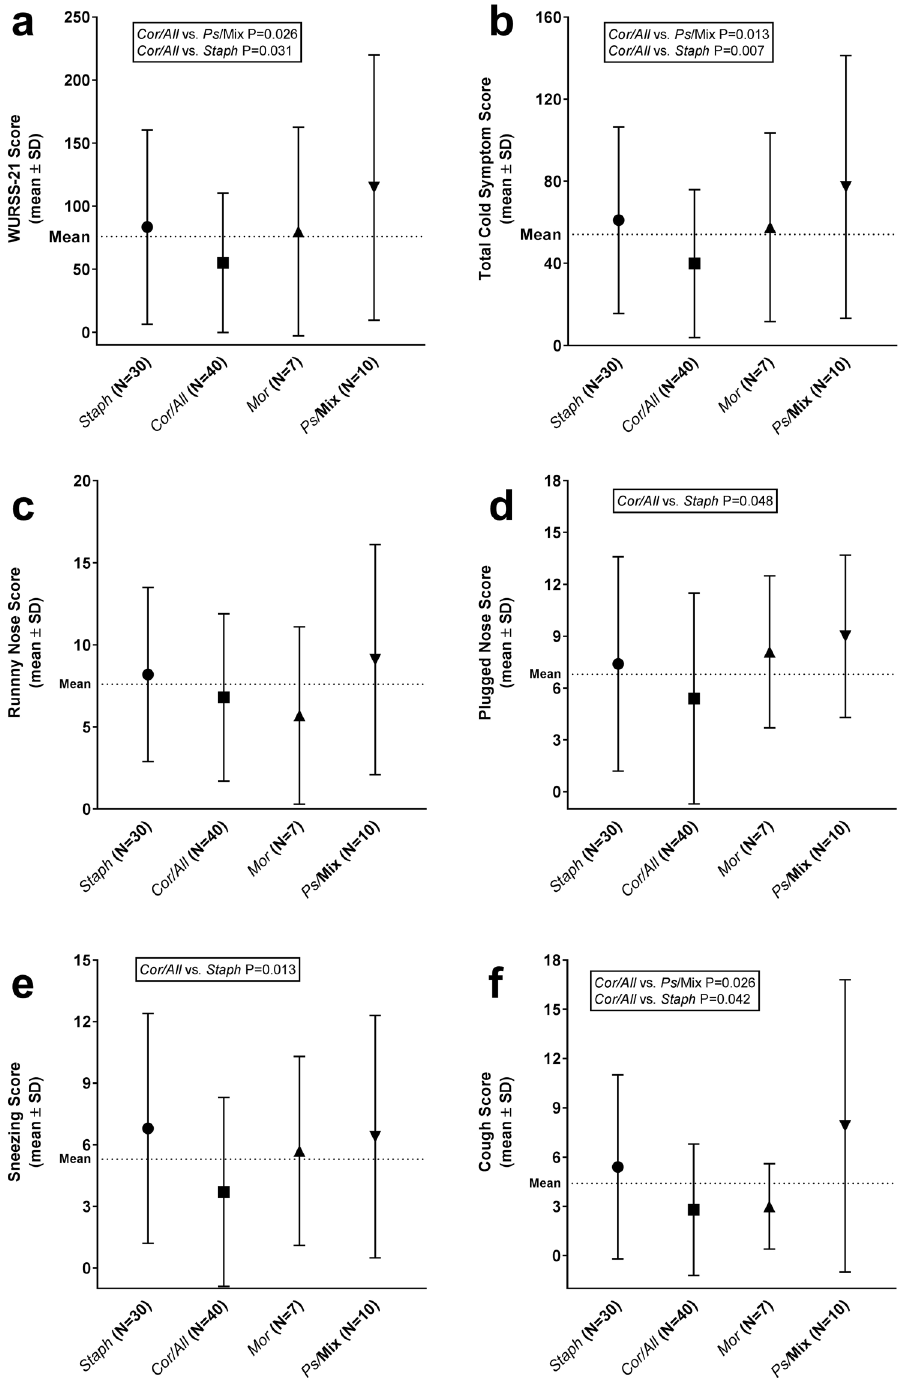
Figure 6. Nasal microbiota cluster and clinical symptoms during rhinovirus infection. The symptom scores for clusters Staph , Cor/All , Mor , and Ps /Mix were evaluated over D1–D5 by using ( a ) WURSS-21 questionnaire. Scores for sub-category ( b ) Total Cold Symptoms, and for individual symptoms ( c ) Runny Nose, ( d ) Plugged Nose, ( e ) Sneezing, and ( f ) Cough in WURSS-21 are shown separately. The statistical testing was performed with negative binomial (GEE)